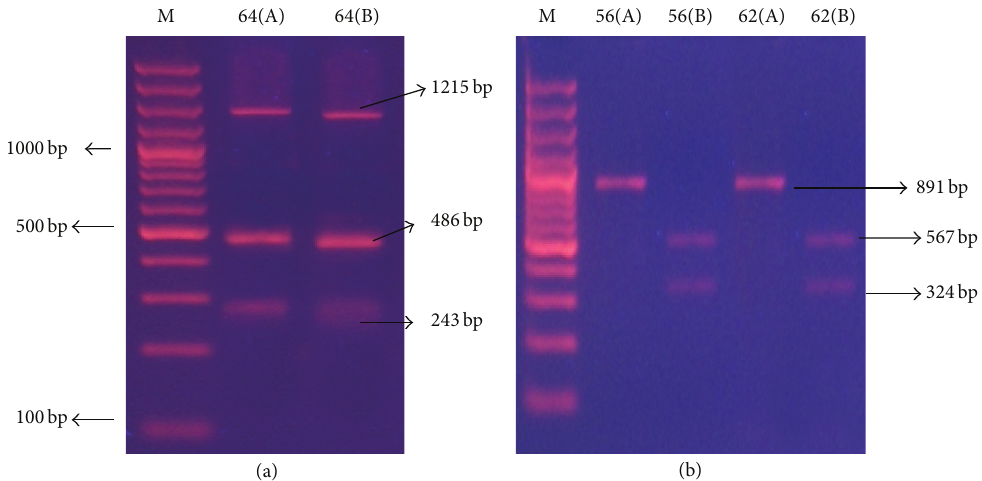
Figure 3: Representative 2% agarose gel electrophoresis of coa gene HaeIII restriction enzyme digestion PCR products, where M is DNA molecular size marker (100 bp ladder), (a) isolate 64 showing 3 bands coa gene PCR products (A) that remained uncut and after (B) cutting with HaeIII restriction enzyme, (b) isolates 56 and 62 showing single band coa gene PCR product (A) and their corresponding 2 bands HaeIII restriction digestion (B).